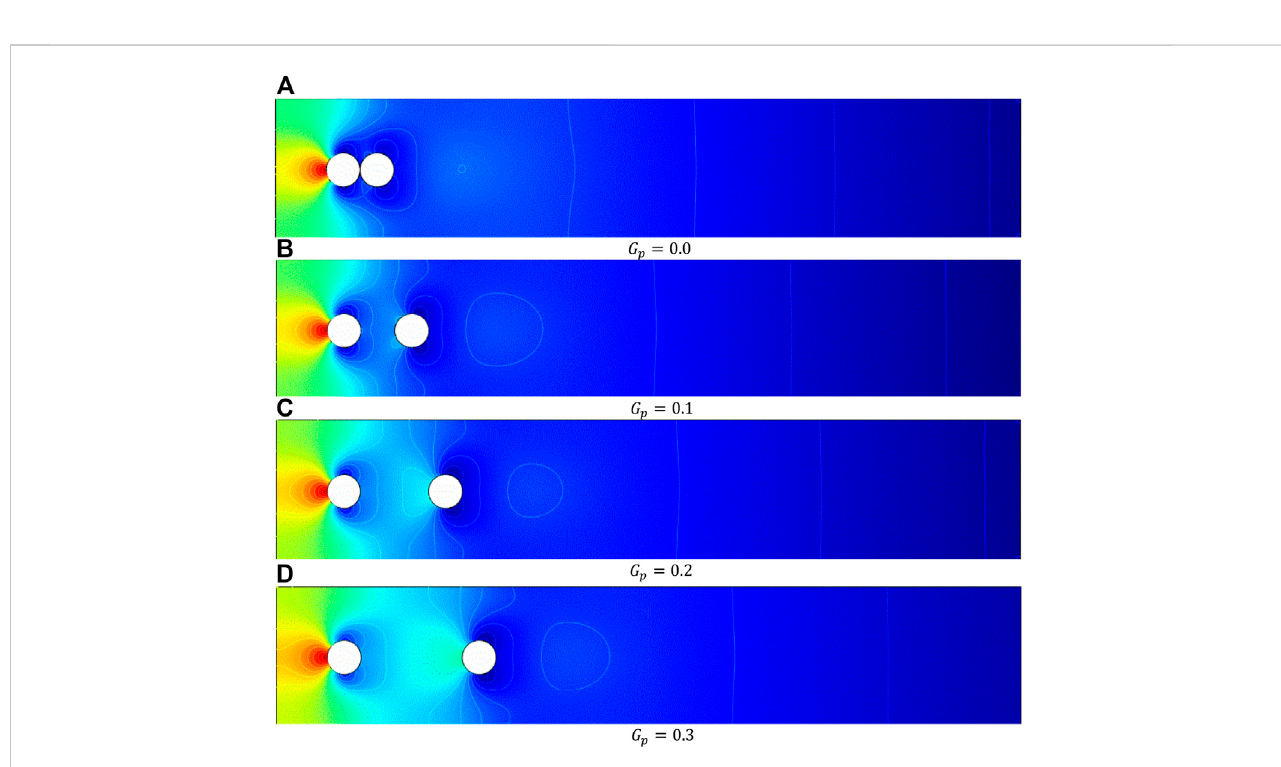
FIGURE 7 In fl uence on pressure for various gap spacings of cylinders with n (cid:2) 1 and Re (cid:2) 20.